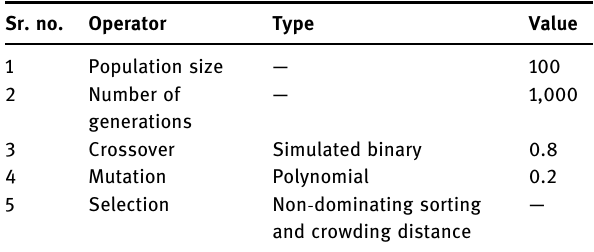
Table 6: Drivers or actuators utilized during NSGA - II Sr. no.